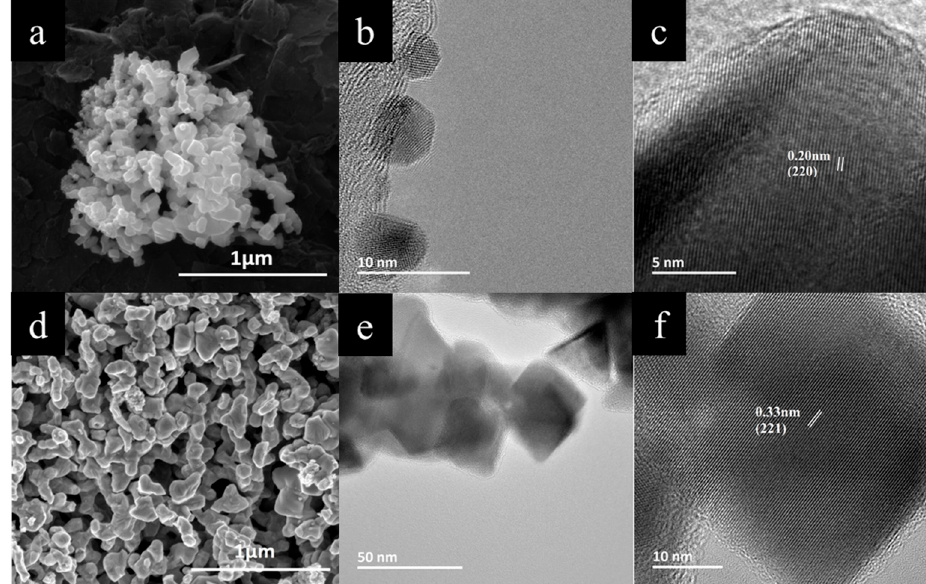
Figure 4 . Scanning electron microscopy (SEM) micrographs of as-made Cu 1.8 Se ( a ) and Cu 2 Se ( d ); TEM micrographs of as-made Cu 1.8 Se ( b – c ) and Cu 2 Se ( e – f ) samples at different magnifications, revealing very fine particle size and high crystallinity. Lattice fringes in Figure 4c are measured as 0.2 nm and indexed for the (220) plane of α -Cu 1.8 Se (ICDD card No. 01-071-0044). Lattice fringes in Figure 4f are indexed for the (221) plane of the monoclinic α -Cu 2 − x Se (ICDD card No. 27-1131). As-made powders were sintered using the SPS technique, which results in